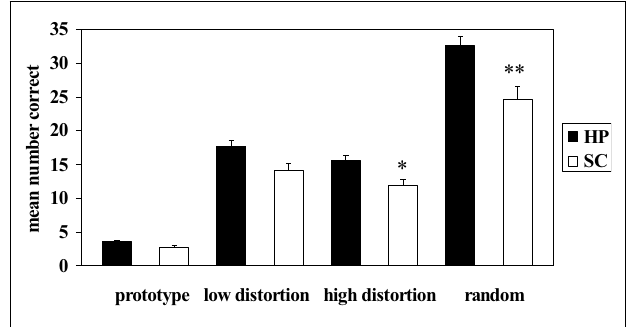
FIGURE 2 | Mean number correct during dot-pattern category judgments in patients with schizophrenia (SC) and healthy participants (HP) . Error bars denote standard error. *SC high distortion correct significantly different from HP high distortion correct, p = 0.003. **SC random correct significantly different from HP random correct, p <